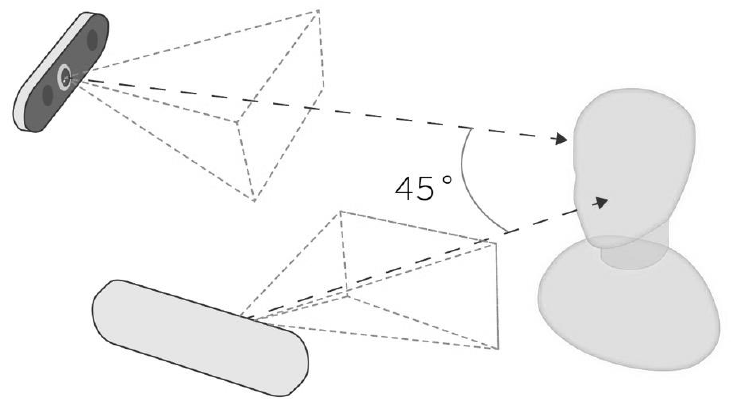
Figure 4. Real face point cloud data acquisition environment. Table 2. The details of test data sets.